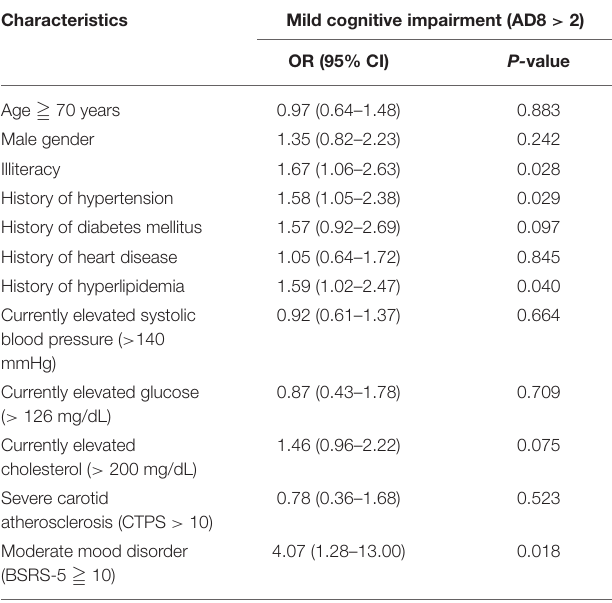
TABLE 7 | Logistic regression of factors influencing mild cognitive impairment in 985 volunteers.